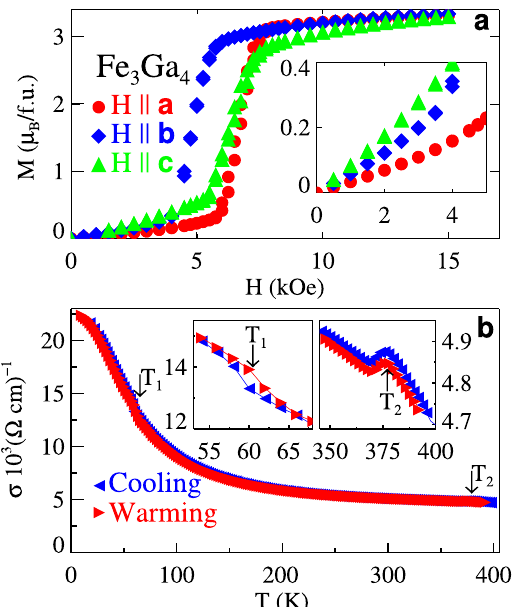
Figure 3. Magnetization Anisotropy and Electrical Conductivity. ( a ) Magnetization, M , vs. magnetic field, H , along the 3 principle crystal axes, a , b , and c , within the incommensurate spin density wave phase at 100 K. ( b ) Temperature, T , dependence of the electrical conductivity conductivity, σ , measured with current along the c - axis. Insets: changes to σ at the magnetic phase transitions. Transition temperatures T 1 and T 2 are